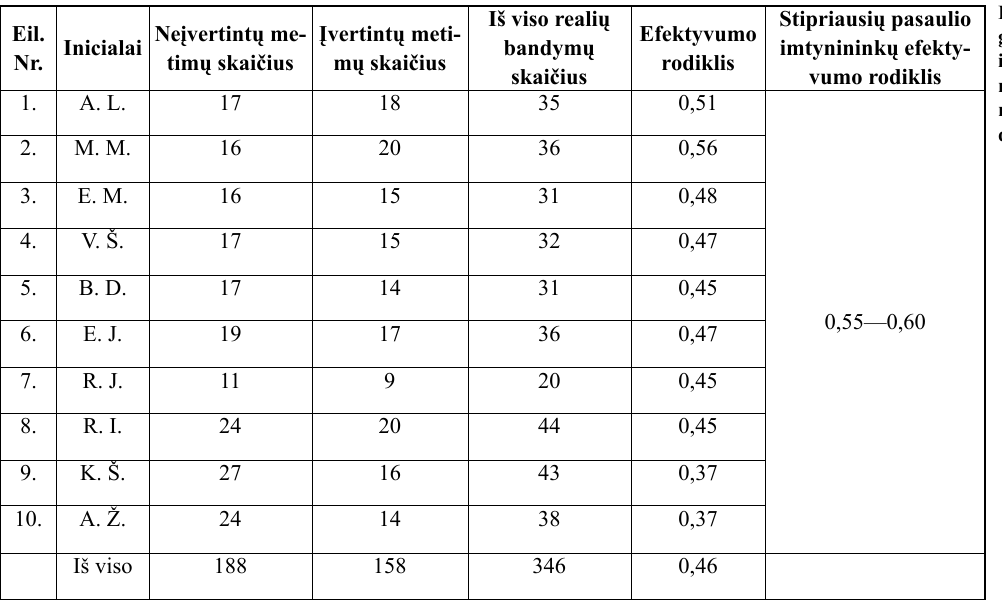
Respublikos rinktin ė s kandidatas V. Š. iš viso reali ų bandym ų atliko 31, iš kuri ų 15 (46,8%) į ver- tinti ir 17 (53,2%) ne į vertinti. 61,2% tenka metimui 38,8% tenka metimams per nugar ą iš kit ų pad ėč i ų